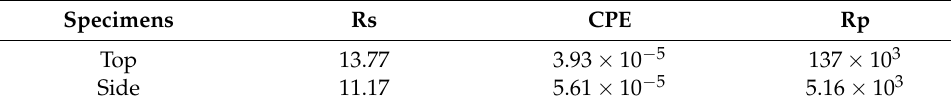
Figure 6. Randle equivalent circuit diagram. Table 6. Fitted parameters obtained from the EIS plots. Table 6. Fitted parameters obtained from the EIS plots.